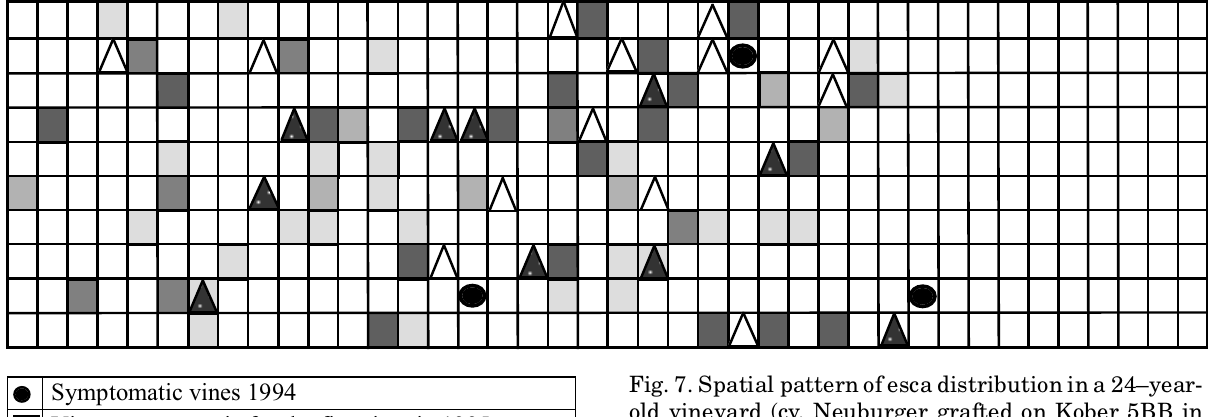
Fig. 7. Spatial pattern of esca distribution in a 24–year- old vineyard (cv. Neuburger grafted on Kober 5BB in the vine-growing area of Vienna 1994-1999). The round dots represent plants known to be diseased at the be- ginning of the investigation. In 1998 no newly diseased plants appeared. Cryptic infections with white-rot fun- gi were also estimated on a sample of visually healthy vines. Some plants without external symptoms, but af- fected with white-rot, exhibited external symptoms one year later. The analysis of the spatial pattern of dis- eased plants revealed a random distribution.